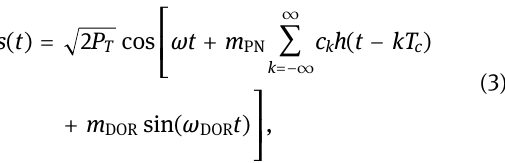
Figure 2: Downlink spectrum and VLBI channels for DOR